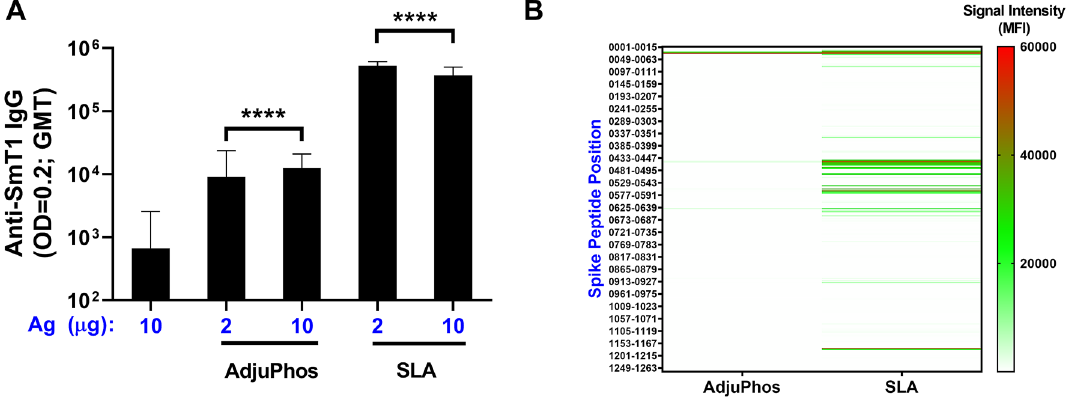
Figure 1. Levels and specificity of antibodies induced by SmT1-based vaccine formulations. C57BL/6 mice (n = 8/group) were immunized i.m. with SmT1 (2 or 10 µg) with or without adjuvant on Days 0 and 21. Serum was collected on Day 28 and analyzed by ELISA to determine the antibody titers ( A ). Grouped data is presented as geometric mean + 95% confidence interval. Statistical significance of differences for the adjuvanted groups vs. the antigen alone control group is shown: ****p < 0.0001 by one-way ANOVA followed by Tukey’s multiple comparisons test. Serum (n = 5–6 per group) was also analyzed by peptide microarray to identify